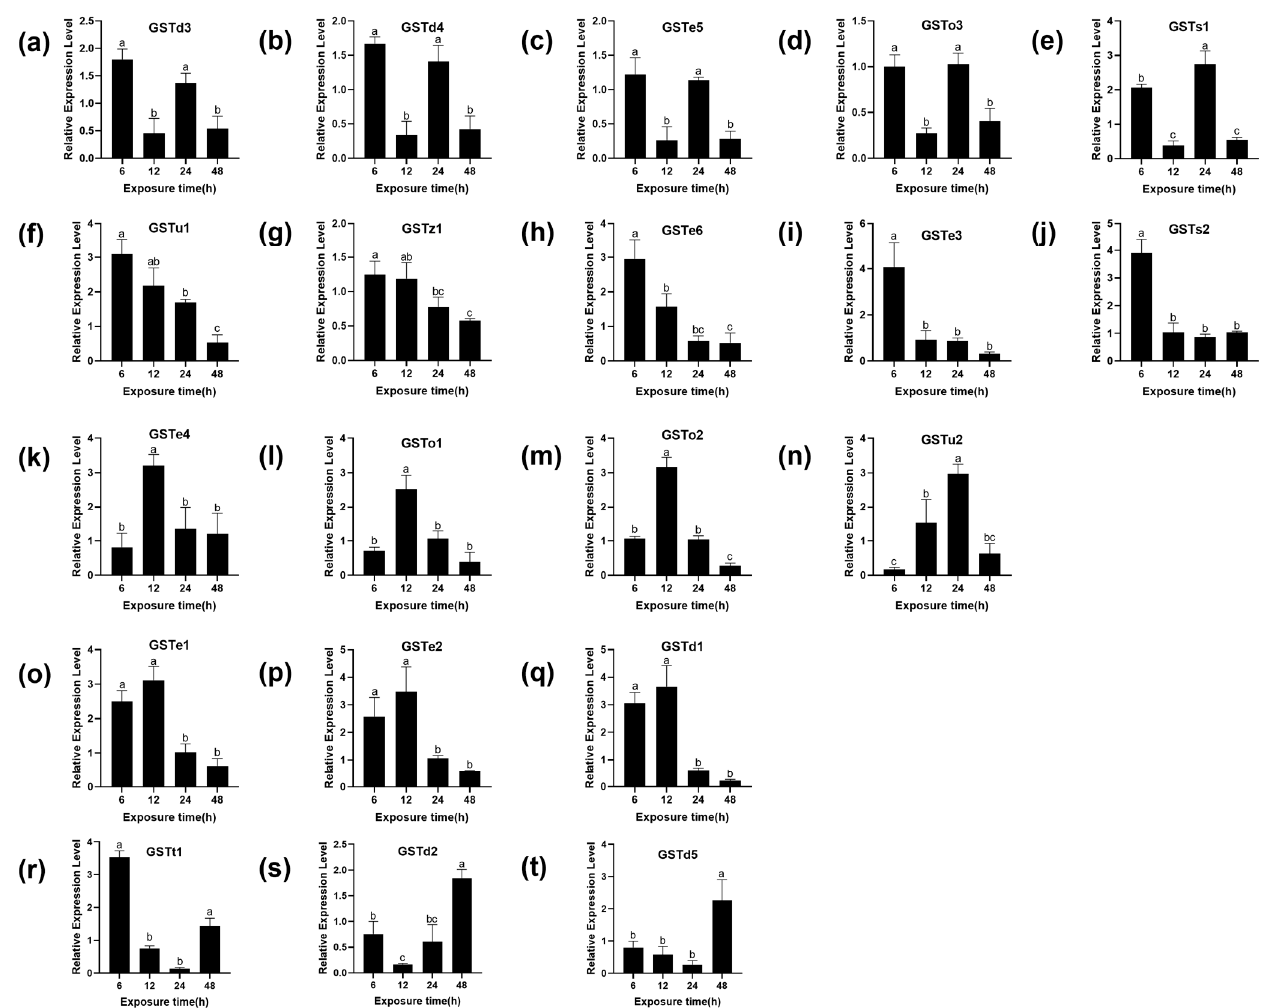
Figure 3. Effects of (S)-( − )-palasonin on the expression level of GSTs genes in Plutella xylostella . GSTd3 ( a ), GSTd4 ( b ), GSTe5( c ), GSTo3 ( d ), GSTs1 ( e ), GSTu1 ( f ), GSTz1 ( g ), GSTe6 ( h ), GSTe3 ( i ), GSTs2 ( j ), GSTe4 ( k ), GSTo1 ( l ), GSTo2 ( m ), GSTu2 ( n ), GSTe1 ( o ), GSTe2 ( p ), GSTd1 ( q ), GSTt1 ( r ), GSTd2 ( s ) and GSTd5 ( t ). (Bars indicate means ± standard errors of replicates. Different alphabets above indicate significant variances ( p < 0.05) calculated with one-way ANOVA, followed by Tukey’s multiple comparison test.).